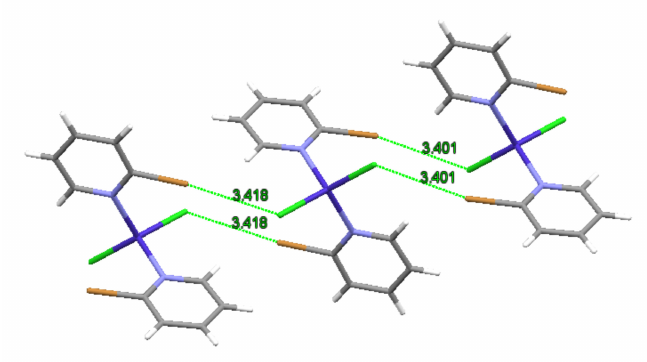
Figure 4. Halogen bonding in crystal structure of [Co(2-BrPy) 2 Cl 2 ] complexes.